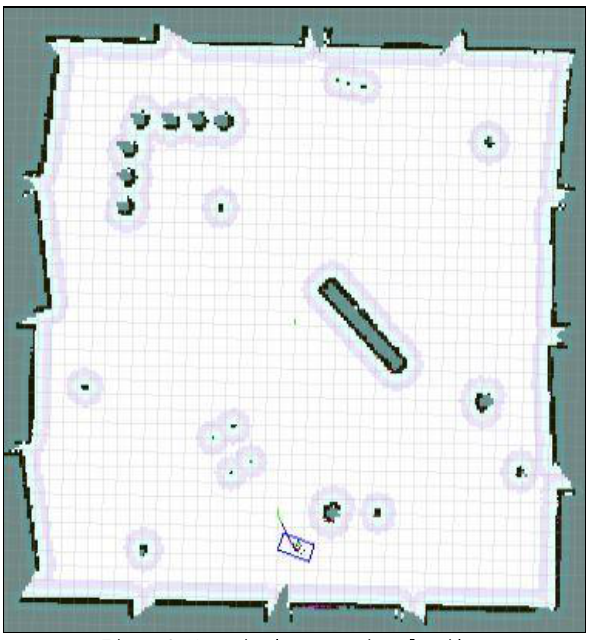
Figure 8. Mapping by gmapping algorithm